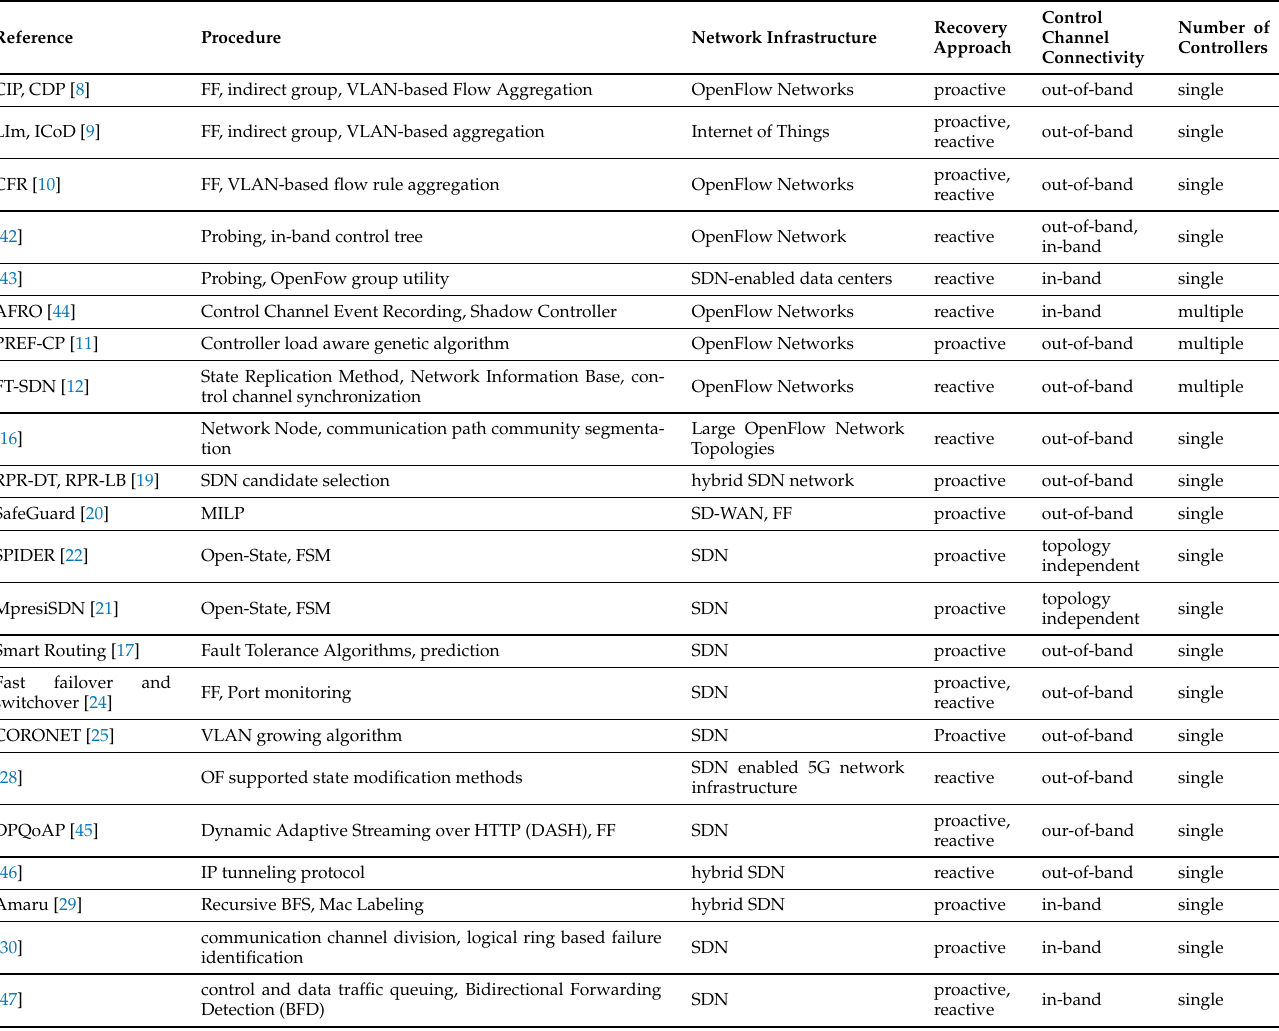
Table 1. Research works focusing the failure resiliency in